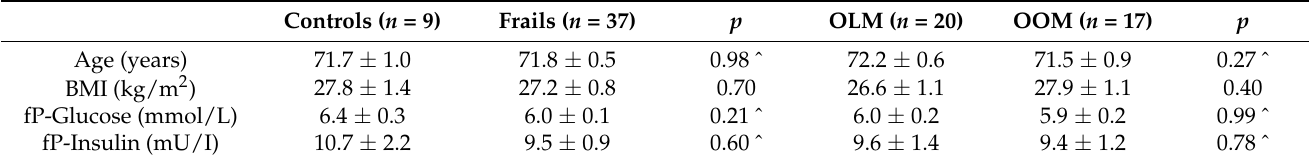
Table 1. General characteristics at baseline; comparisons between groups.